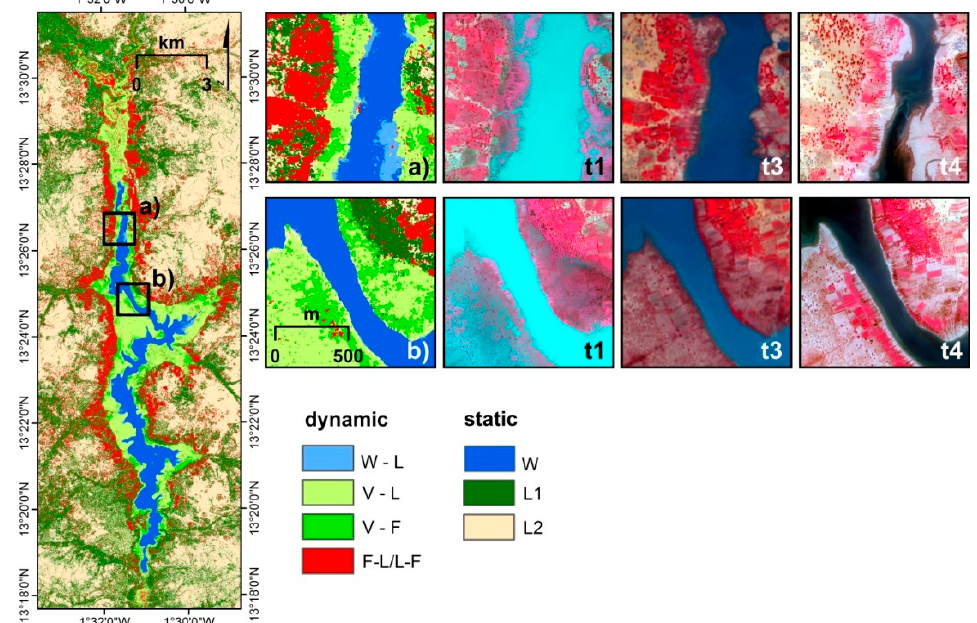
Figure 12. Multitemporal classification for the time series stack of the year 2014–2015 resulting in seven change classes: open water (W); water to land/soil (W–L); flooded vegetation to land/soil (V– L); flooded vegetation to irrigated fields (V–F); and irrigated fields to land/soil or land/soil to irrigated fields (F–L/L–F); land with permanent vegetation (L1); and land with soil, rock, urban (L2). Two